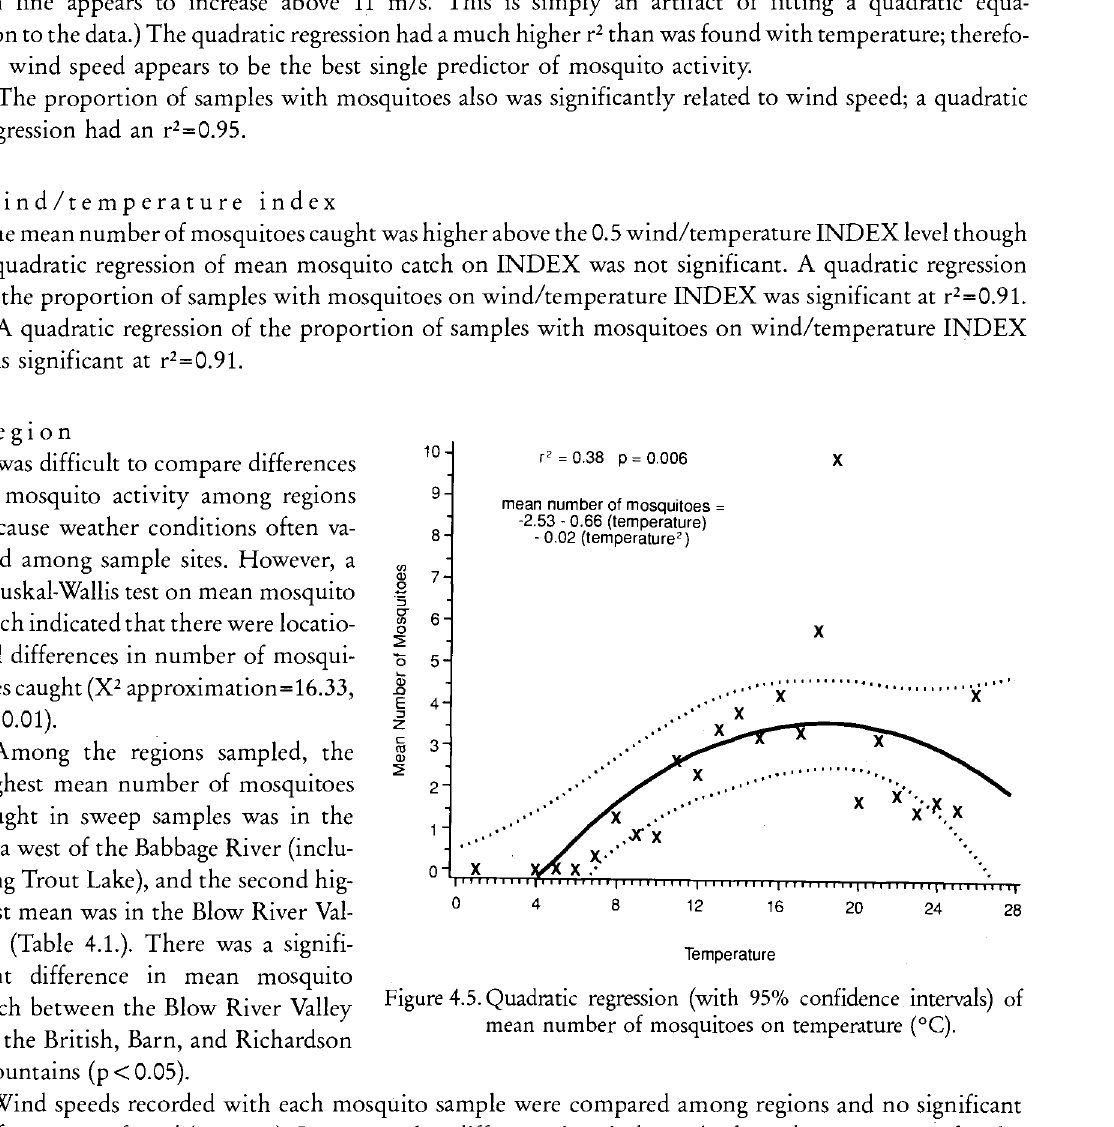
Figure 4.5. Quadratic regression (with 95% confidence intervals) of mean number of mosquitoes on temperature